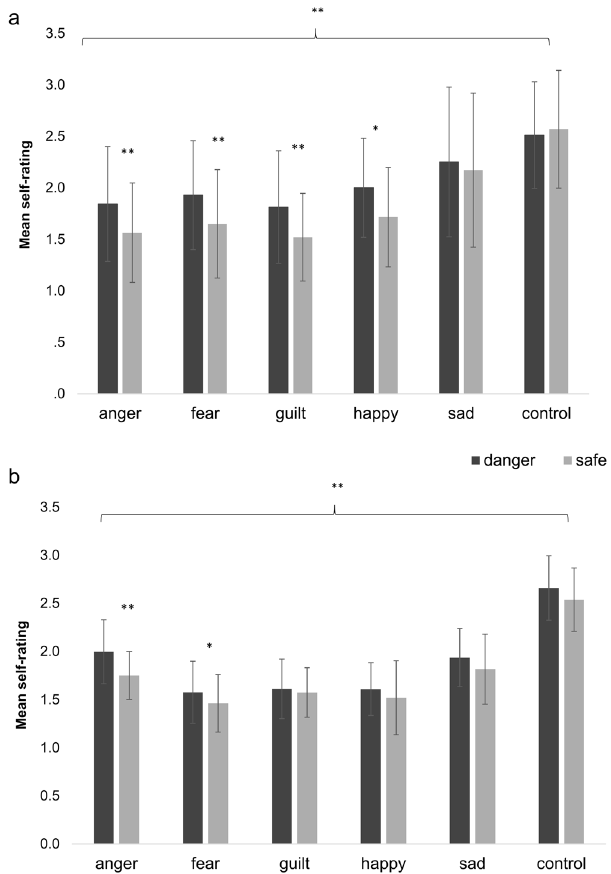
Figure 4. Effect of danger condition on emotion self-rating. ( a ) In Experiment 1, there was a main effect of emotion, block number, and danger condition, with danger condition increasing subjective emotion rating for both negative ( p < 0.001) and positive ( p = 0.04) emotions ( b ) In Experiment 2, there was a main effect of emotion and danger condition, with danger condition generally increasing subjective emotion rating for both negative ( p = 0.003) and positive emotions ( p = 0.039). * p < 0.05 (does not survive Bonferroni correction for multiple comparisons); ** p < 0.001 (survives Bonferroni correction for multiple comparisons). Error bars represent 95% confidence intervals.